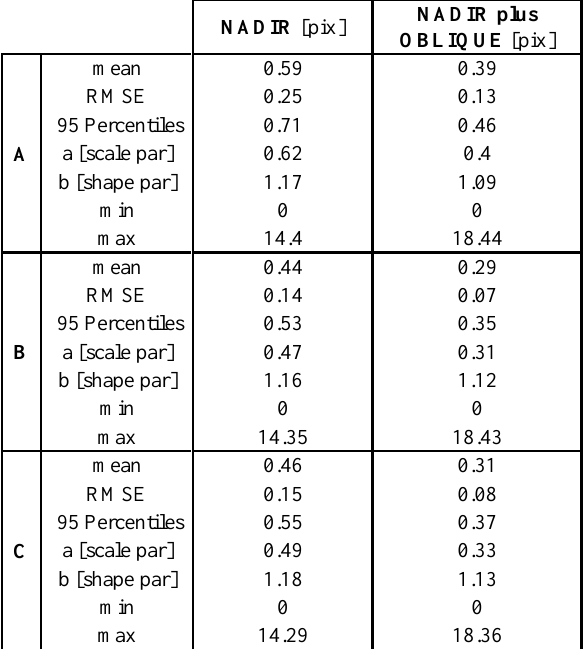
Figure 9: The box plots of the 3D GCP residuals. Tab. 2: Statistical parameters on the analysis of reprojection errors.